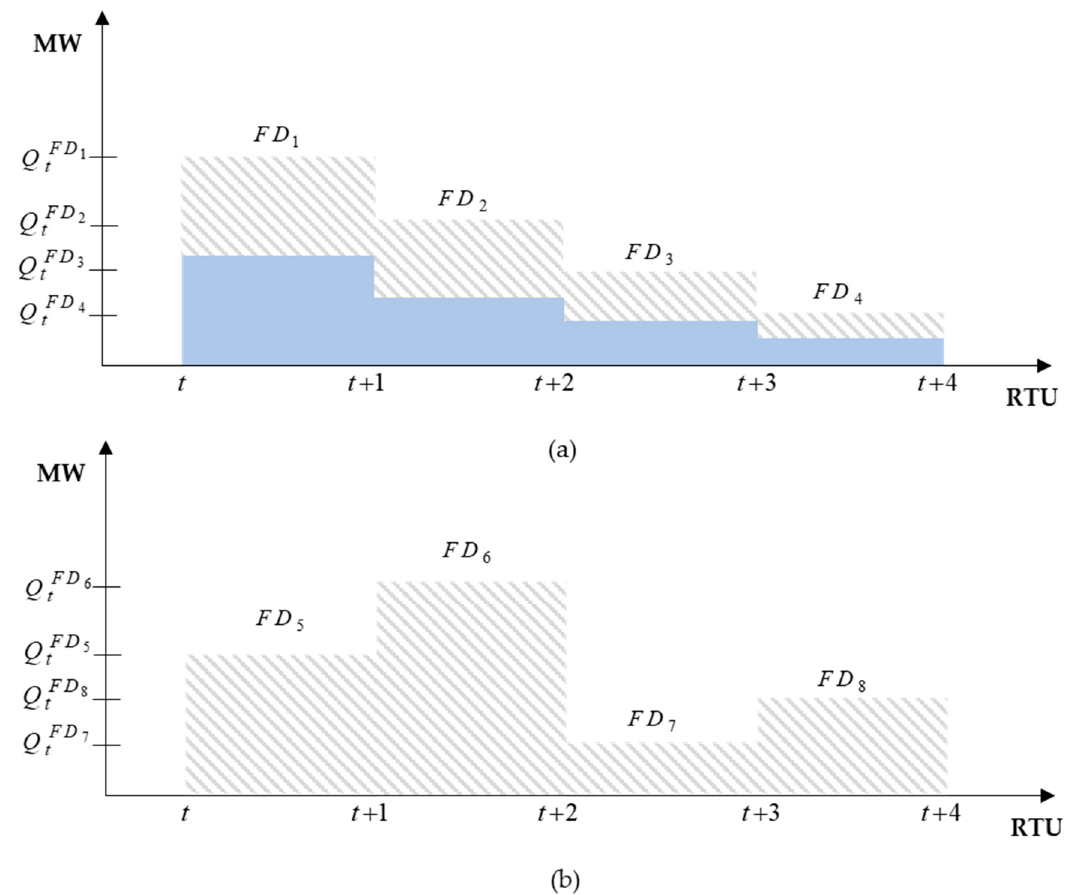
Energies 2020 , 9 , x FOR PEER REVIEW Figure 7. ( a ) Linked in time fully divisible order 1; ( b ) linked in time fully divisible order 2.